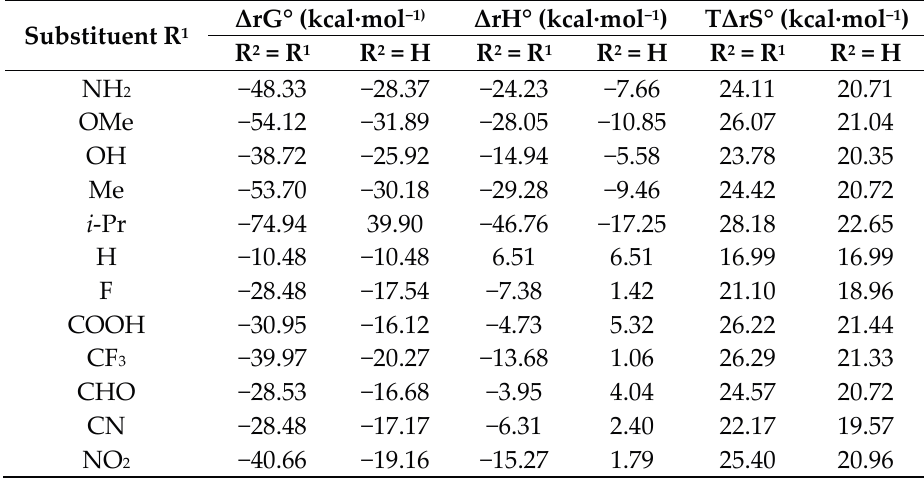
Table 3. Standard Gibbs energies Δ rG°, enthalpies Δ rH°, and entropies T Δ rS° of the aromatization reaction of the DA cycloadduct 4 in Scheme